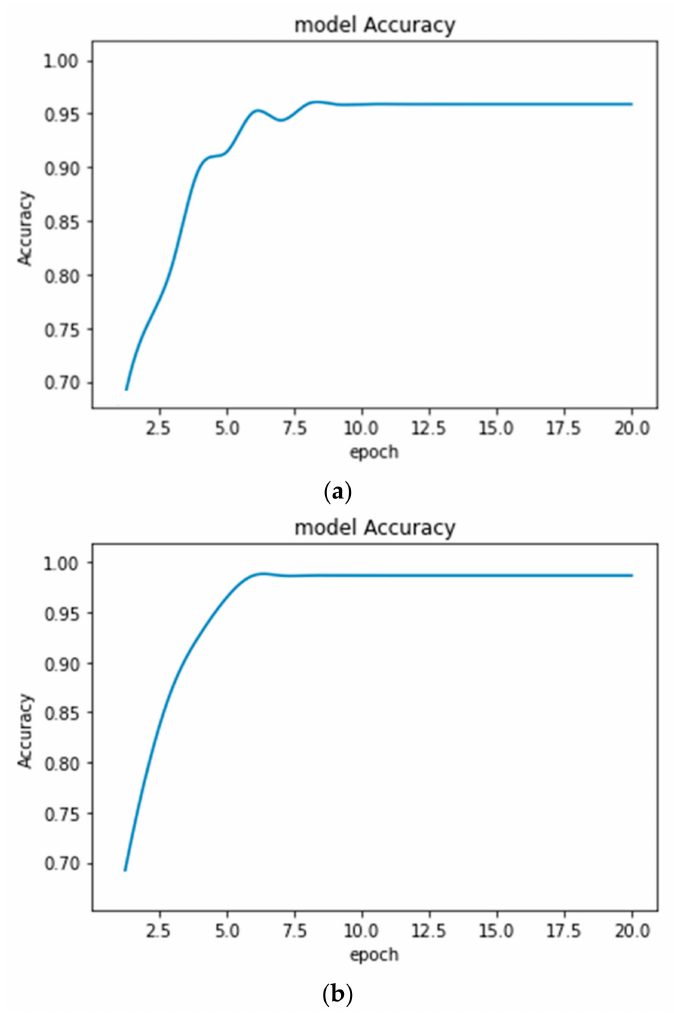
Figure 10. Accuracy plots obtained for Brain MRI classification ( a ) with an earlier form of CE (Accuracy = 95.48%) and ( b ) with improved CE (Accuracy =